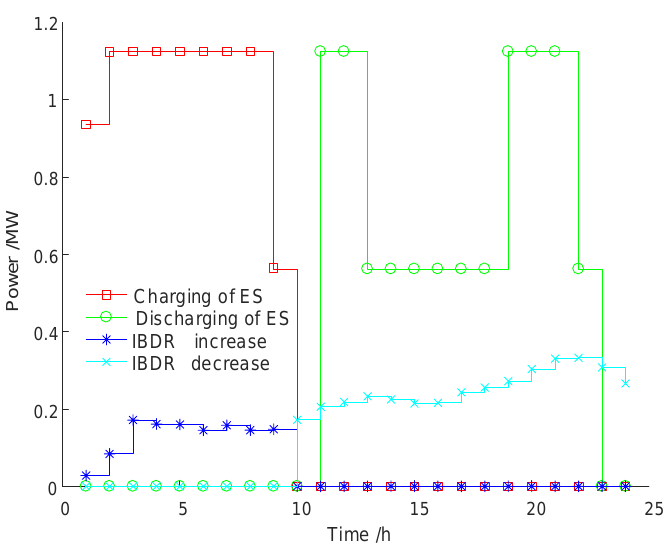
Figure 5. ES and IBDR simulation operation.